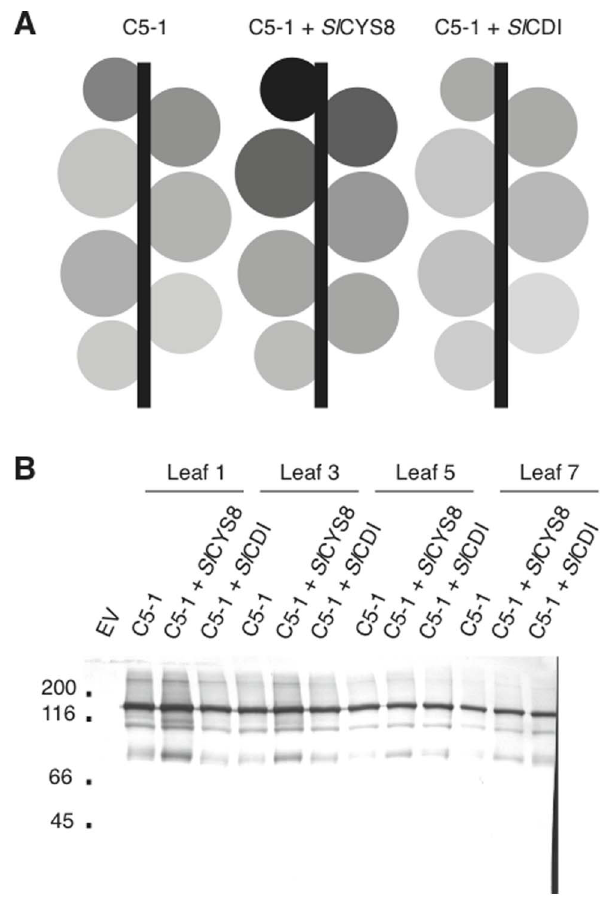
Figure 5. Biological activity of C5-1 expressed alone or along with Sl CYS8 or Sl CDI. (A) Plants are represented as schematic diagrams, where the area of each circle represents the weight of the corresponding leaf. Levels of grey represent relative C5-1 activities (absorbance units) on a total soluble protein basis, as measured by ELISA and normalised to the maximum amount obtained. Each value is the mean of three biological replicates. (B) Immunodetection of C5-1 activity at 6 dpi in Leaf 1, Leaf 3, Leaf 5 and Leaf 7, with the recombinant antibody expressed alone or along with Sl CYS8 or Sl CDI. Antibody activity was inferred from binding of human IgG following electroblotting of non-reduced SDS-PAGE-separated proteins onto nitrocellulose sheets. The human IgG antigen of C5-1 was then detected with a goat anti-human conjugated with alkaline phospha- tase. EV, mock infiltration with an empty